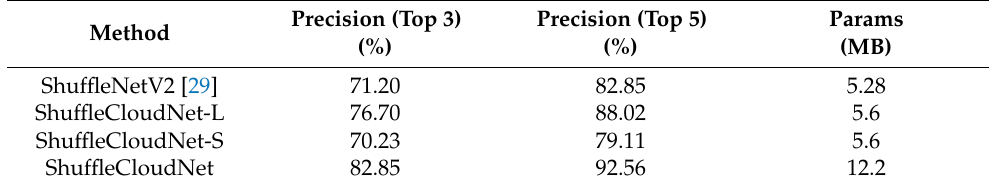
Table 3. Effects of the ShuffleNet module with different combinations on the CTI_RSCloud